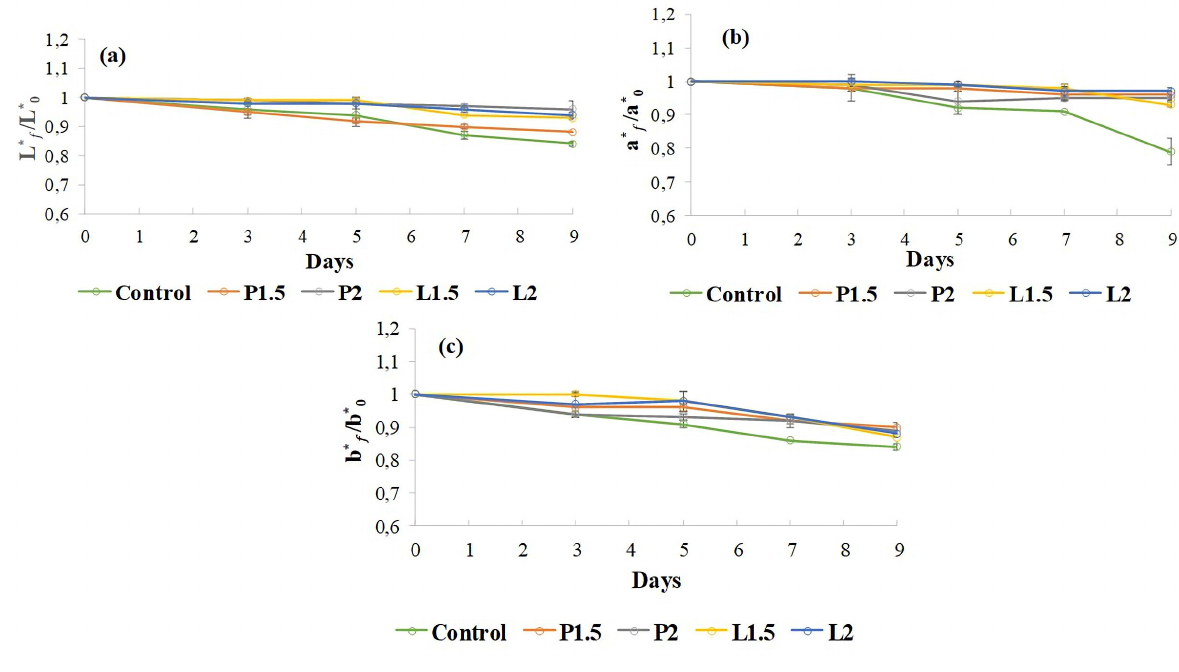
/ L L ) (A), parameter a* ratio ( * * 0 f